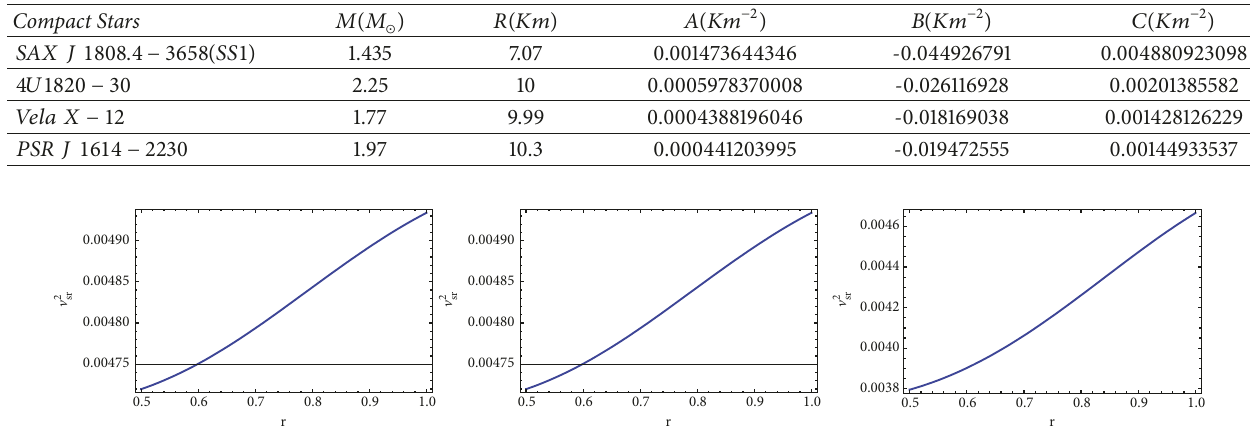
Table 1: The values of 𝐴 , 𝐵 , and 𝐶 have been obtained using (37).